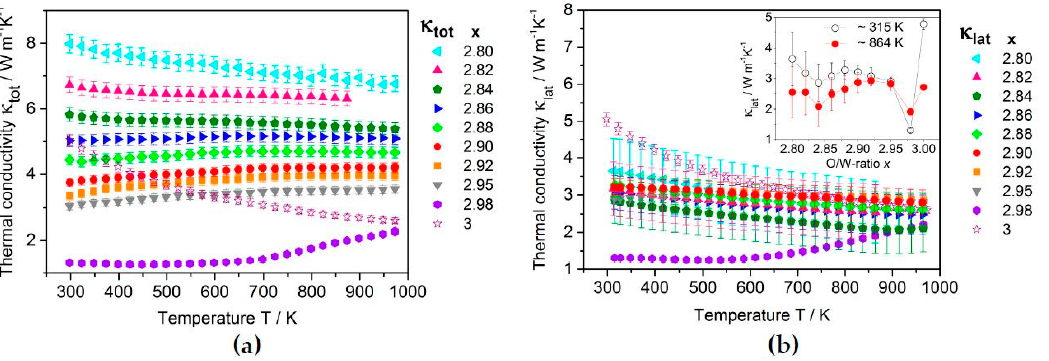
Figure 10. Thermal conductivity of the WO x samples (2.80 ≤ x ≤ 3): ( a ) Total thermal conductivity κ tot ( T ); ( b ) Lattice contribution κ lat = κ tot − κ el with κ el from the Wiedemann-Franz law. The inset shows the dependency κ lat ( x ) for 315 K and 864 K.